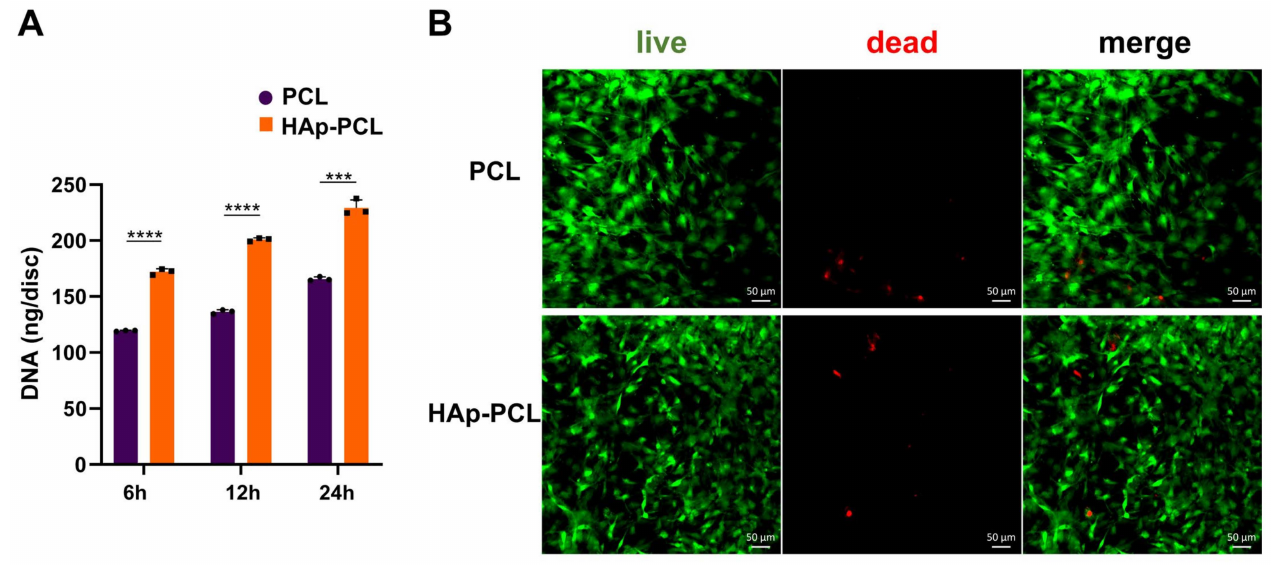
Figure 3. Assessment of initial cell attachment and cell viability after seeding on PCL-based discs. ( A ) Initial attachment of rBMSCs after seeding on discs of PCL or HAp-PCL. *** p < 0.001, **** p < 0.0001: significant difference between two groups at the corresponding time. ( B ) Viability of rBMSCs cultured on discs of PCL or HAp-PCL for 24 h, evaluated by the live/dead assay. Scale bar is 50 µ m.